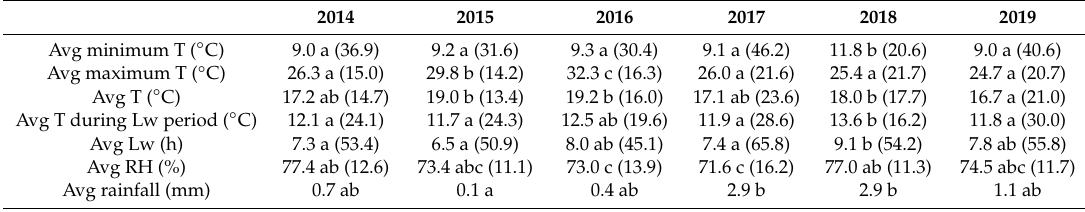
Table 4. Meteorological data by potato crop